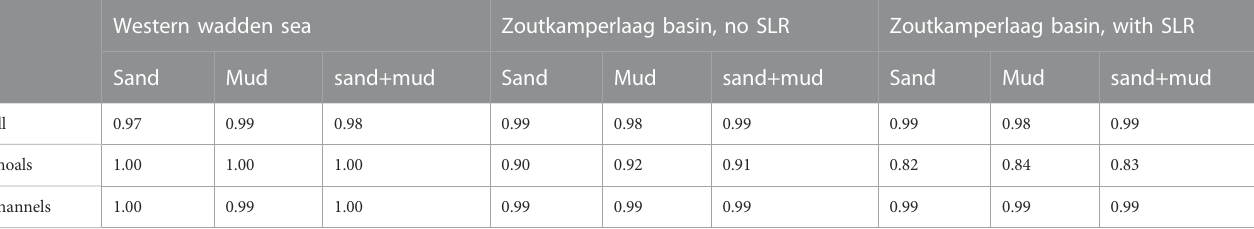
TABLE 2 R 2 values for the fi tted functions in Figure 8 (Western Wadden Sea), Figure 9 (Zoutkamperlaag basin without SLR), and Figure 10 (Zoutkamperlaag basin with